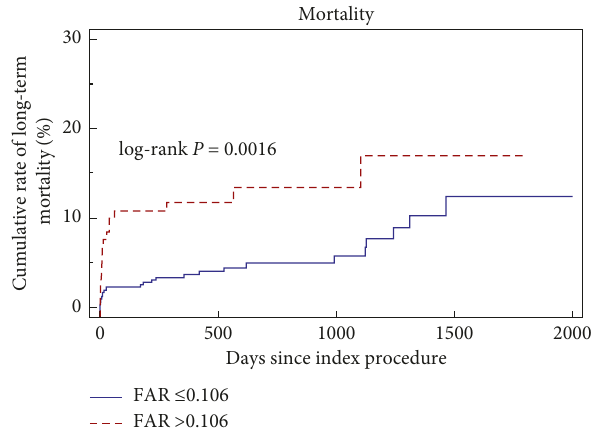
Figure 2: Kaplan–Meier curves demonstrate the cumulative mortality for patients based on the cutoff value of FAR levels (0.106).